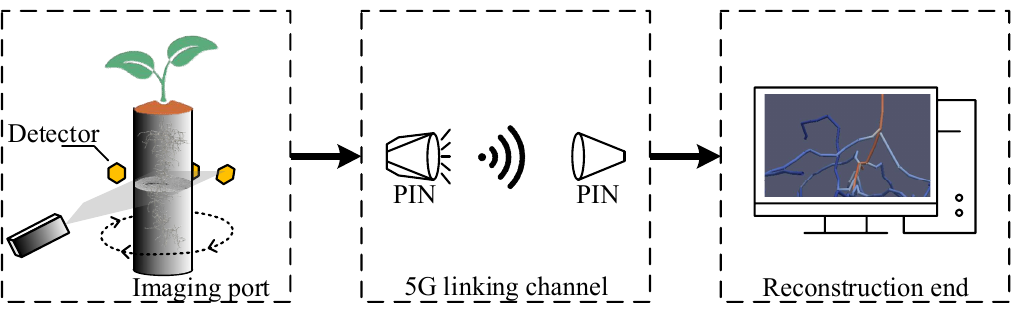
Figure 7. Model of the high-throughput image transmission.